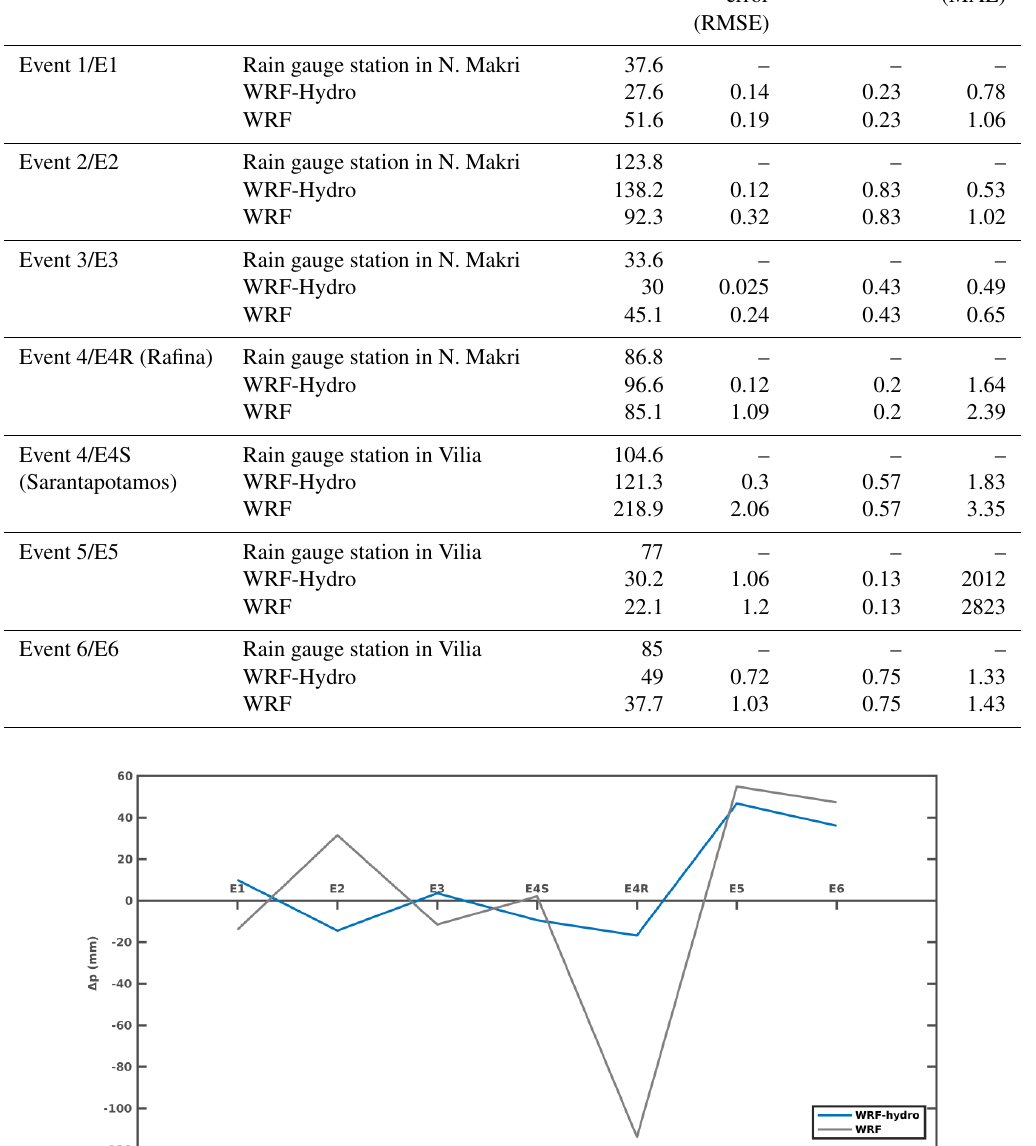
Figure 9. The difference between observed and simulated (WRF-Hydro and WRF) total amount of precipitation per event for gauge stations of Vilia and N.